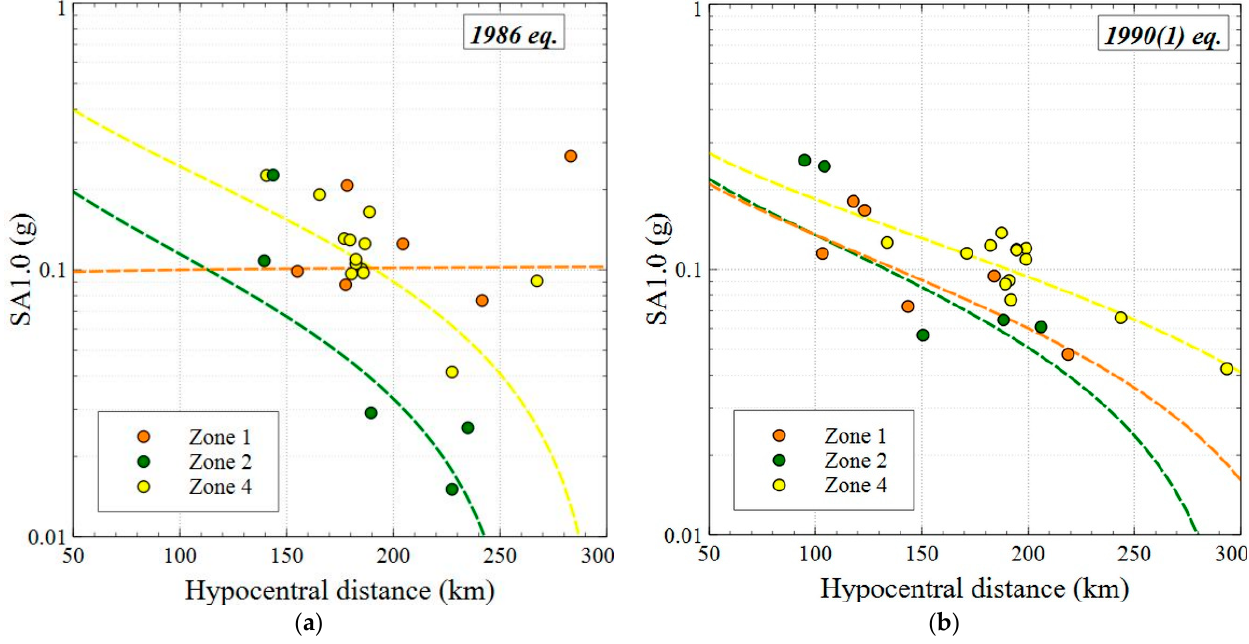
Figure 8. Comparison between the hypocentral distance attenuation curves for the spectral acceleration at 1.0 s for: ( a ) the 1986 Vrancea earthquake; ( b ) the 1990(1) Vrancea earthquake. With dashed lines are shown the corresponding logarithmic fit curves.